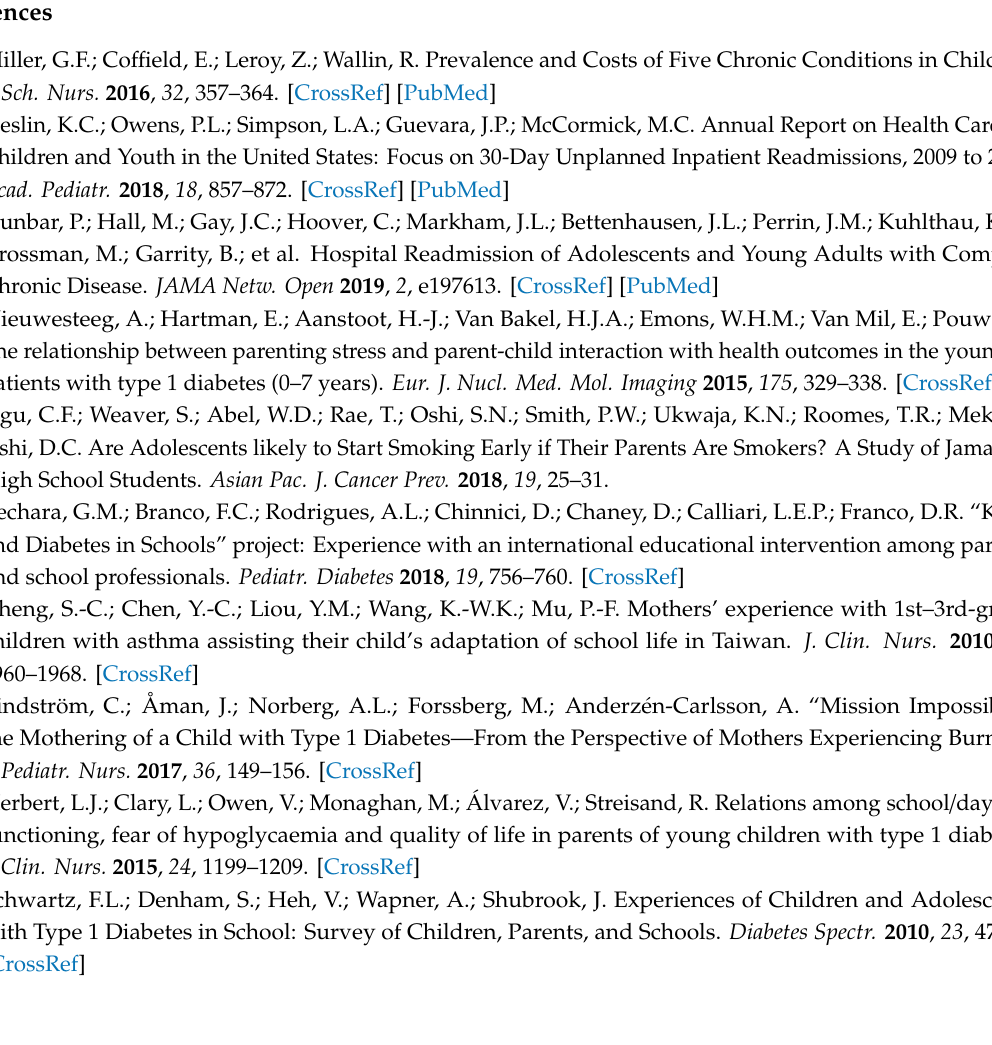
Table S1: Critical appraisal of potentially selected articles, Table S2: Summary of the included